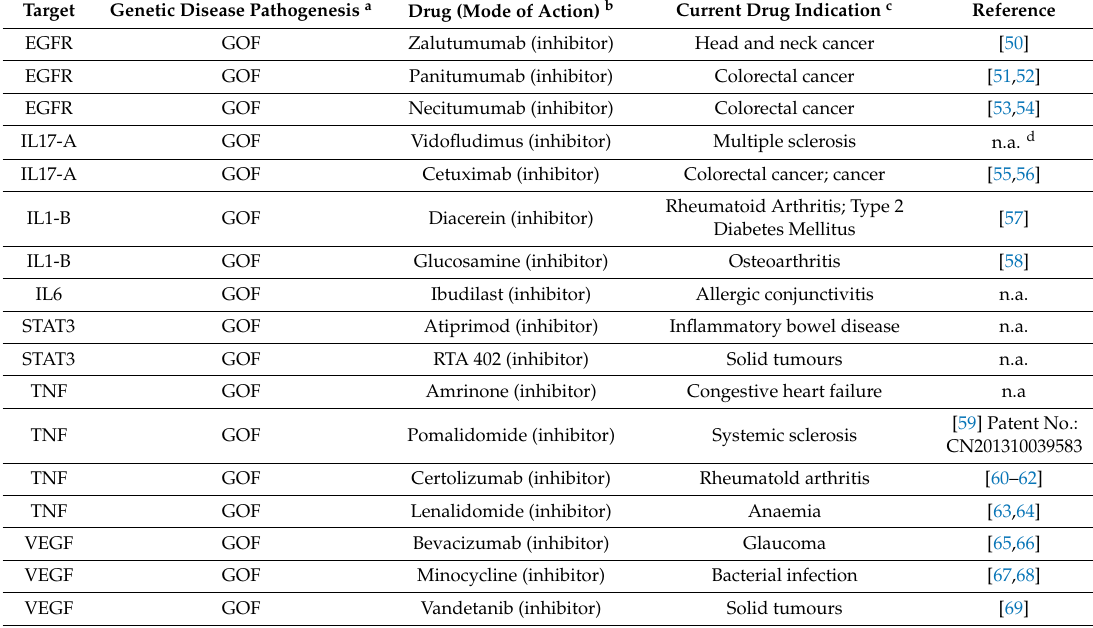
Table 3. Potential anti-psoriasis drugs predicted by medical genetics of targets and related literature/patents.